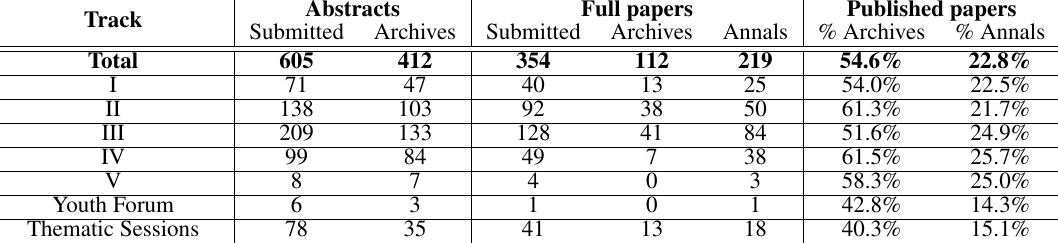
Table 2. Detailed statistics for each